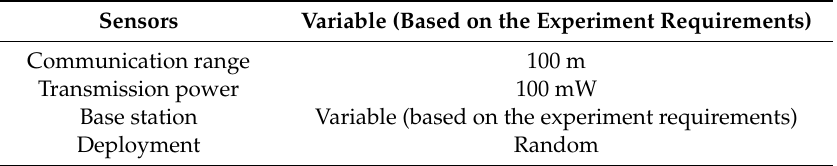
Table 1. General sensor network